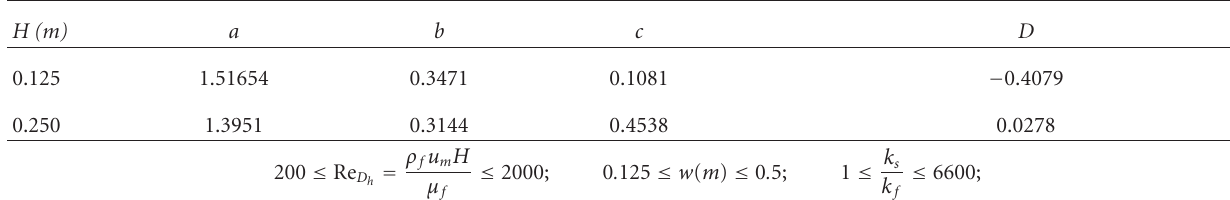
Table 3: Constants (a)–(d) for formula (45) along with the Ranges of the Parameters [154]. H (m) a b c